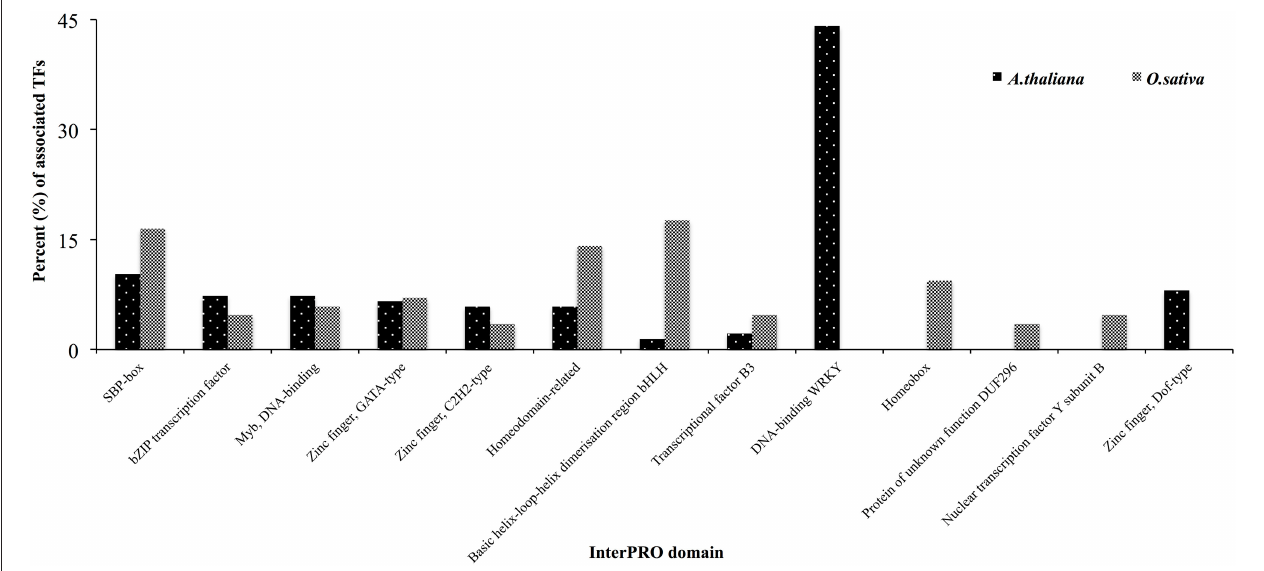
FIGURE 3 | Classification of TFs based on InterPRO analysis in A. thaliana and O. sativa . Percent of TFs associated to the promoters of all four HMR genes were presented.